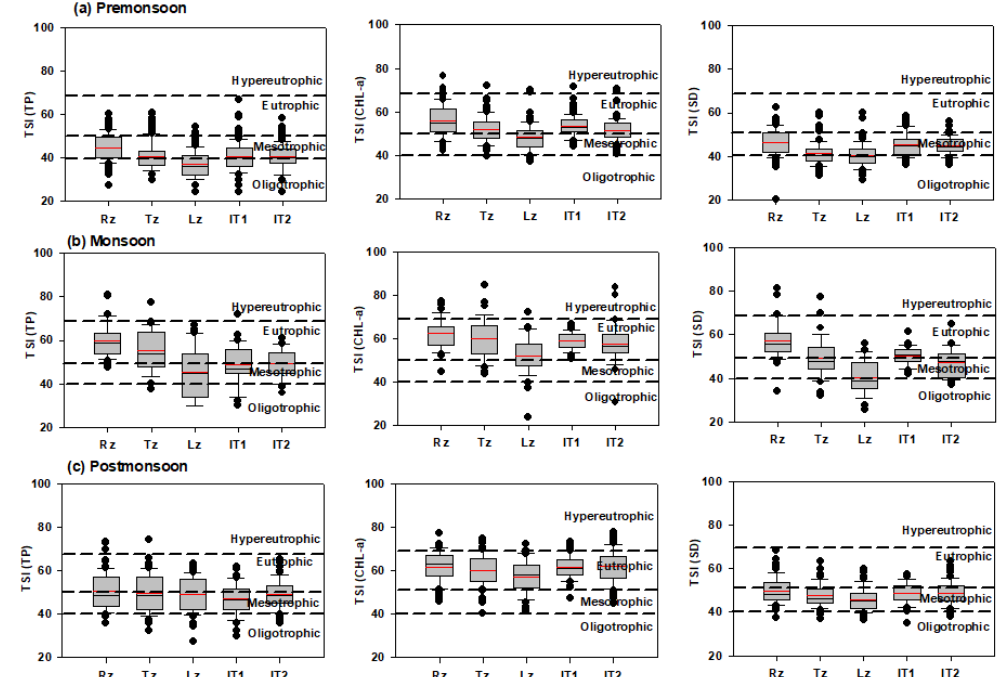
Figure 7. Trophic state index based on total phosphorus (TP), chlorophyll-a (CHL-a), and Secchi depth (SD) of the Daecheong Reservoir from 2000–2018 during the ( a ) premonsoon (January-June), ( b ) monsoon (July-August), and ( c ) postmonsoon (September-Decmber) seasons. (Rz: riverine zone, Tz: transitional zone, Lz: lacustrine zone, IT1, and IT2: intake tower for drinking water 1 and 2). Red lines in the box indicate the mean value. The analysis of trophic state index deviation (TSID) indicated that blue-green algae were dominated in the reservoir during the premonsoon, monsoon, and postmonsoon seasons based on the relationship between TSI (CHL-a)—TSI (SD) and TSI (CHL-a)—TSI (TP) (Figure 8). During the monsoon and postmonsoon seasons, the concentrations of smaller particles, non-algal turbidity, and zooplankton grazing were minor in Rz, Tz, Lz IT1, and IT2. The yearly TSID analysis points out that, during the premonsoon season, the blue-green algae was dominated over the study period (Figure 9). Whereas, during monsoon and postmonsoon seasons, the zooplankton grazing happened in the years of 2016 and 2018, respectively.